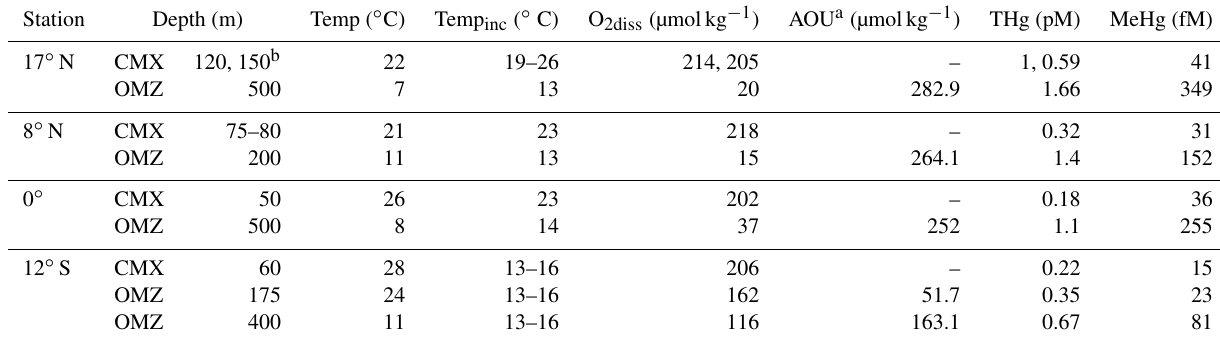
Table 1. Water column characteristics for Pacific Ocean waters from which potential mercury methylation rates were measured. Station